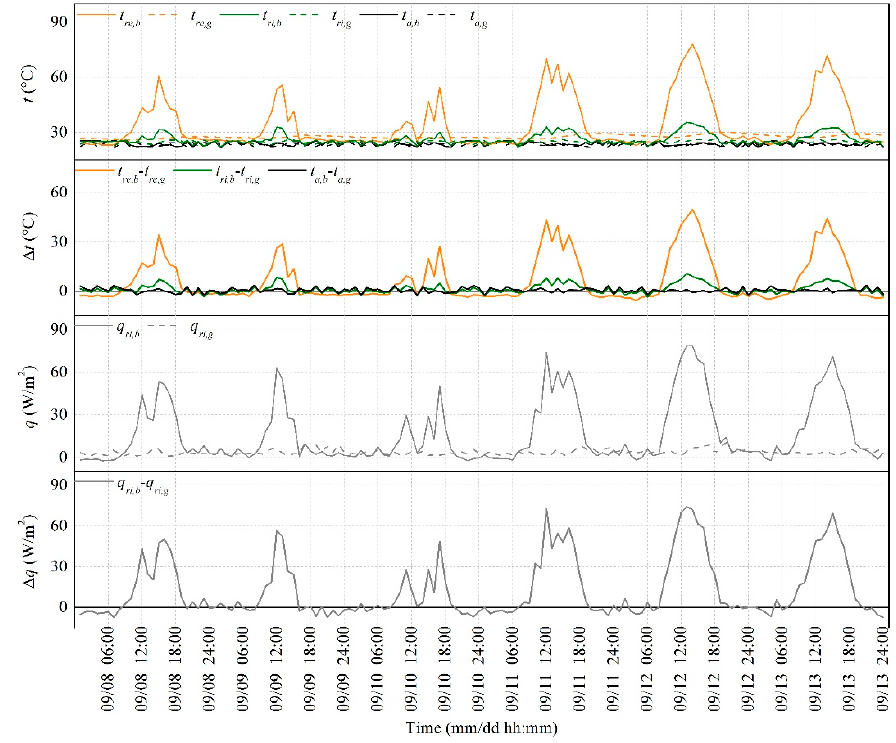
Figure 7. Cooling benefits of the green roof in the air-conditioning experimental conditions. t re,b , t ri,b , and t a,b : external surface, internal surface, and chamber air temperature of the bare roof, respectively; t re,g , t ri,g , and t a,g : external surface, internal surface, and chamber air temperature of the green roof, respectively; q ri,b : internal surface heat flux of the bare roof; and q ri,g : internal surface heat flux of the green roof.